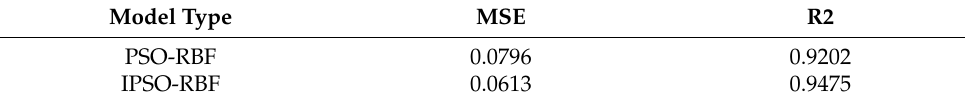
Table 7. The comparative result between the two models.